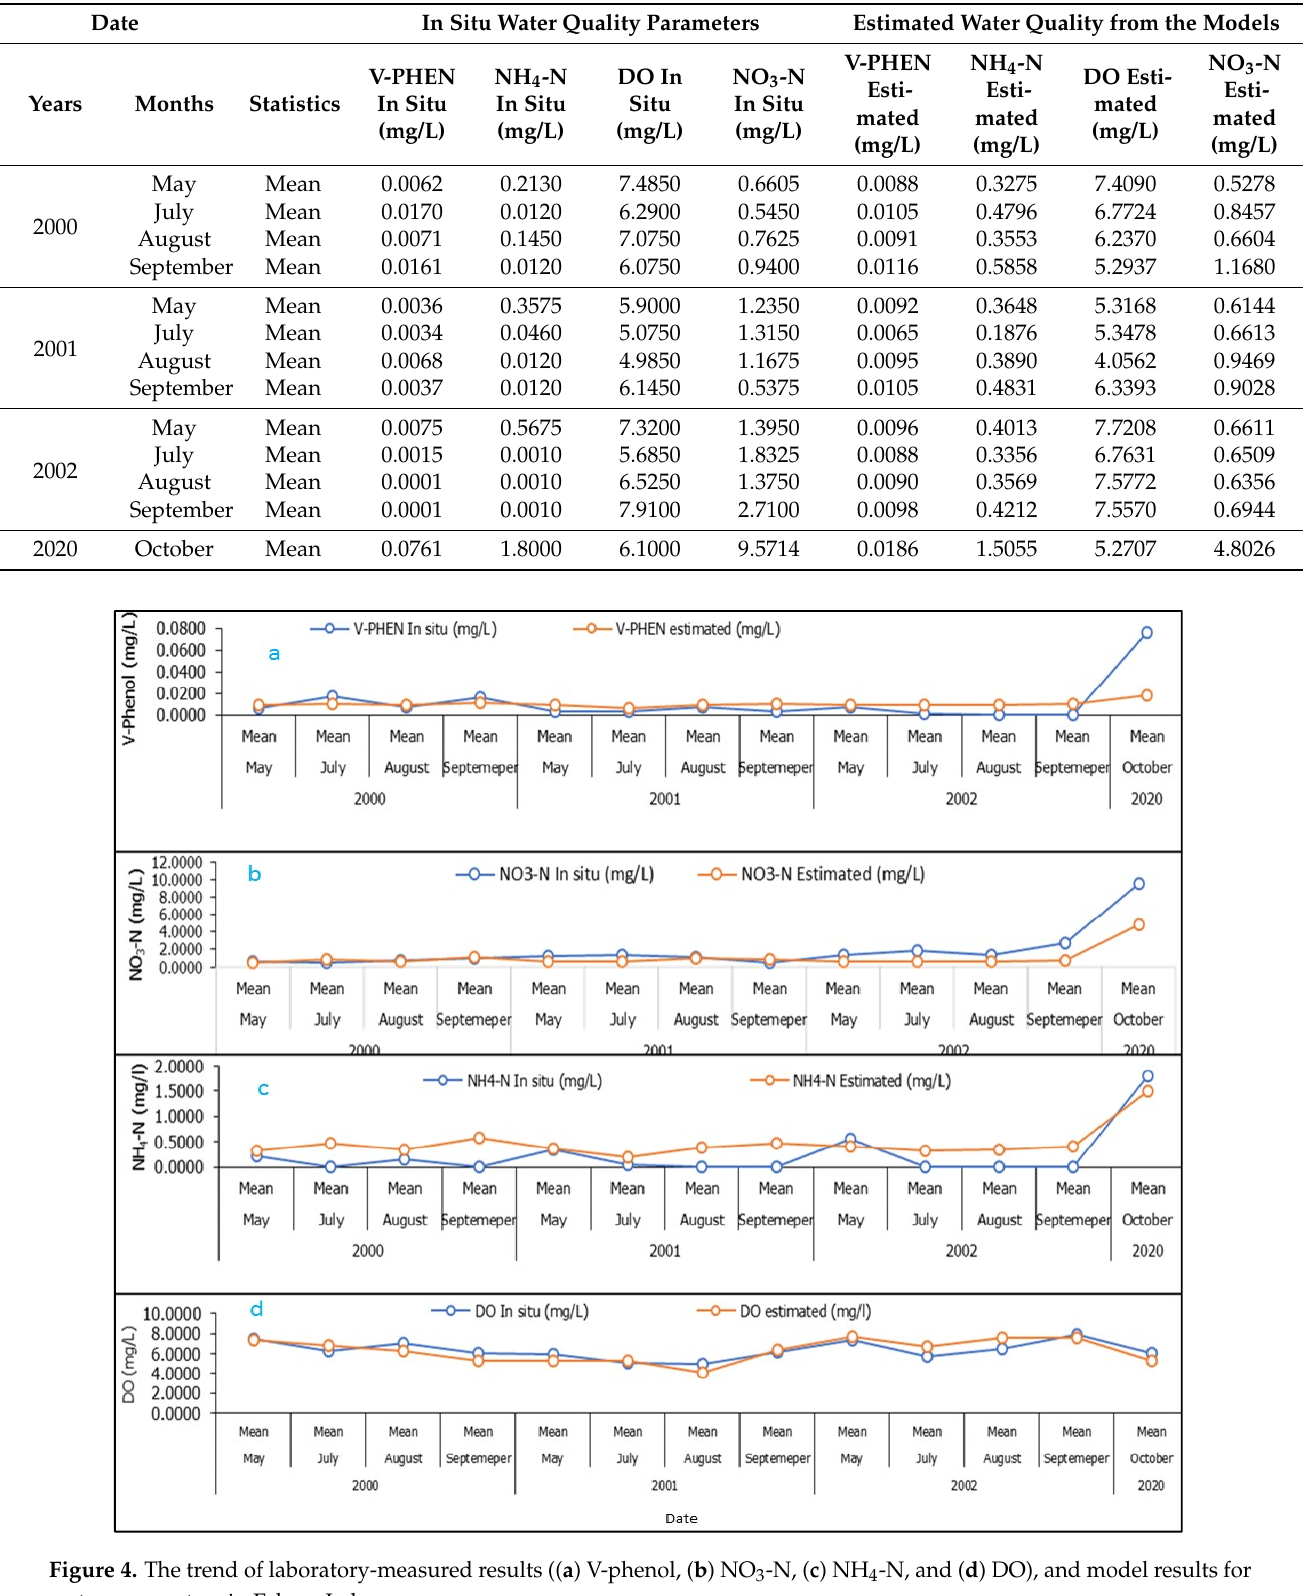
Table 4. Mean values of water quality from in situ measurements and mean values generated from the models along Erlong Lake.